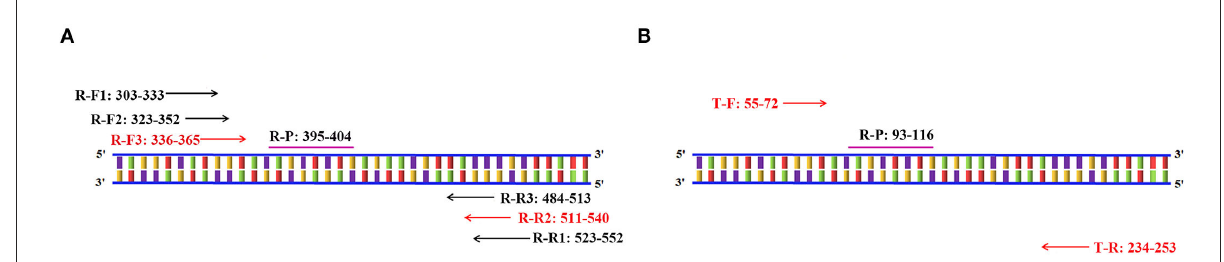
FIGURE1 Schematic diagram of primer amplification. (A) Schematic diagram of the RT-RAA primer screening. The numbers in the primer name represent the position of the oligonucleotides in the conservative region of the VP6 gene. (B) Schematic diagram of Taqman probe-based RT-qPCR primers amplification. The numbers in the primer name represent the position of the oligonucleotides in the conservative region of the VP6 gene.